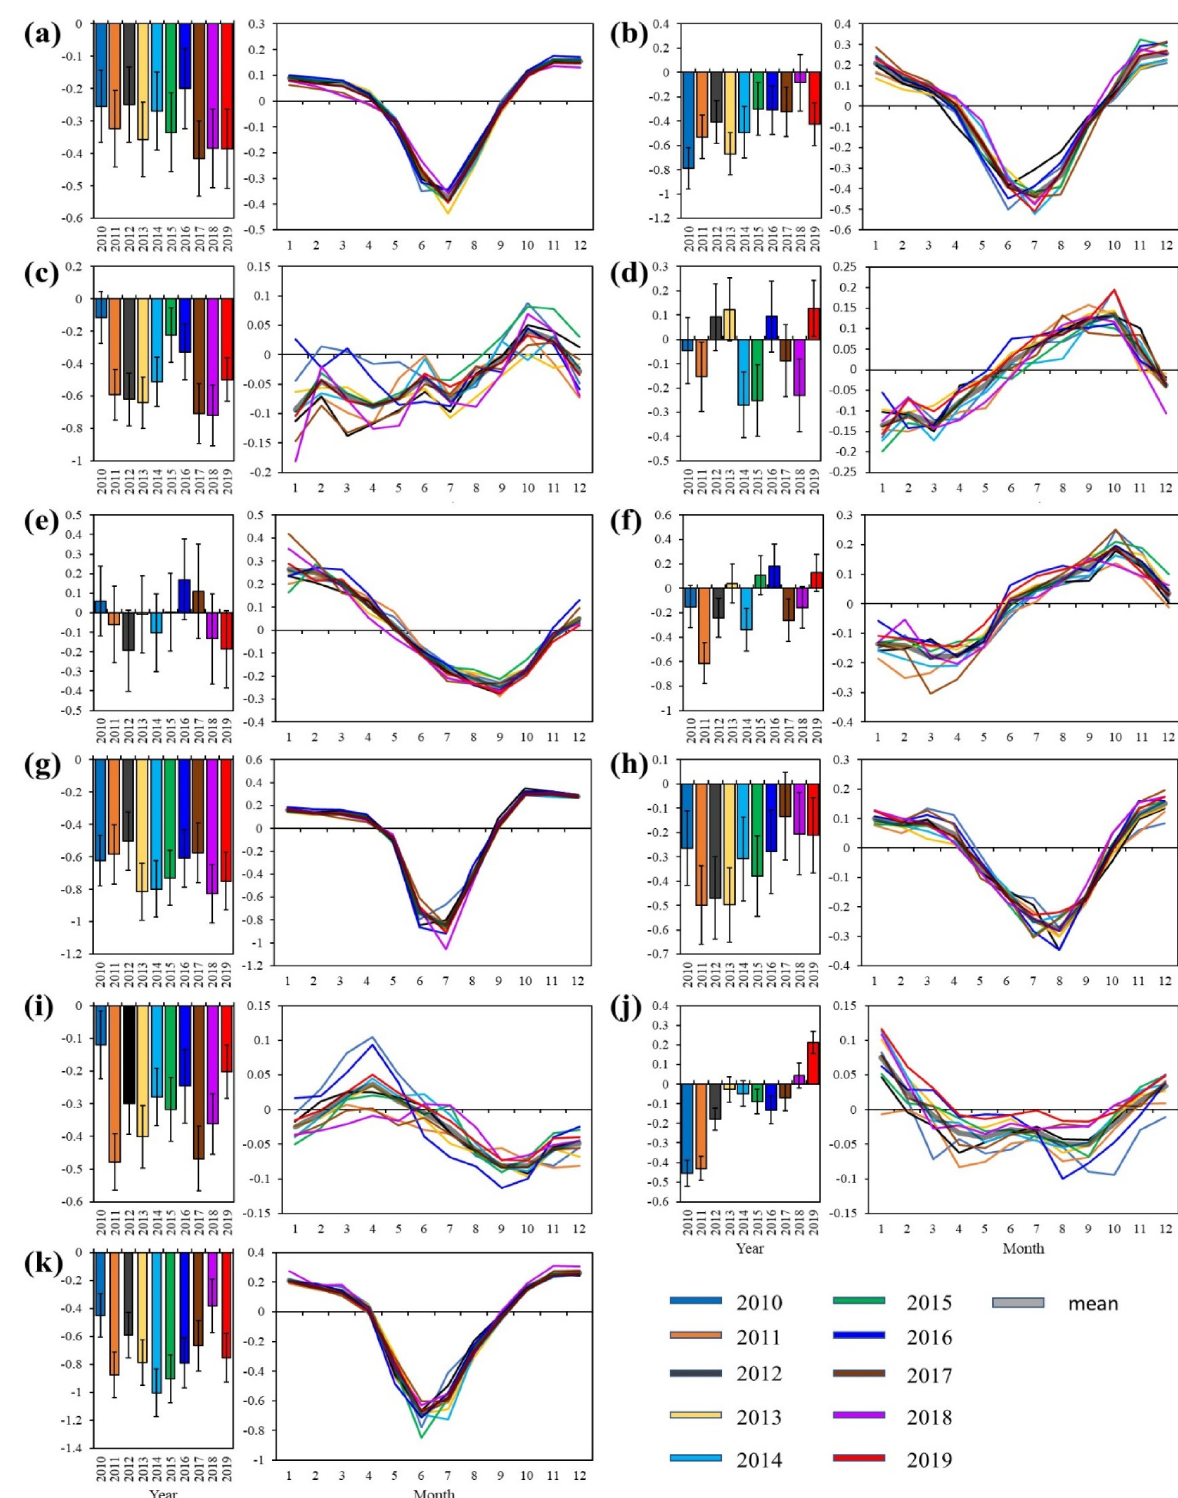
Figure 8. Interannual variations of the annual (unit: PgCyr − 1 ) and monthly (unit: PgC per month) NEE in the 11 TRANSCOM regions ( a boreal N. America; b temperate N. America; c tropical S. America; d temperate S. America; e northern Africa; f southern Africa; g boreal Asia; h temperate Asia; i tropical Asia; j Australia; k Europe).